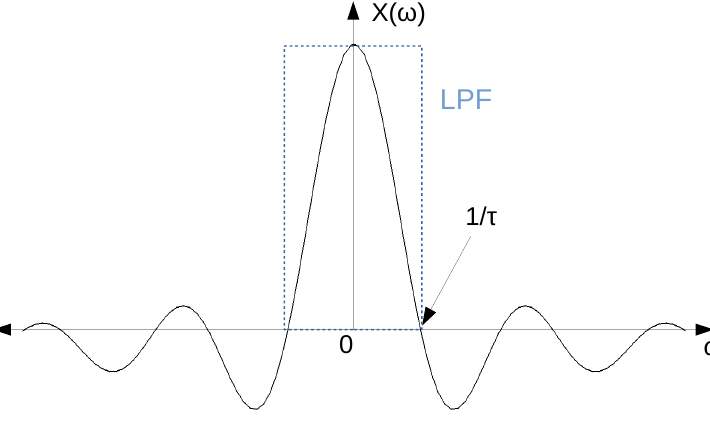
Figure 8. Frequency response of a square pulse and an ideal low-pass